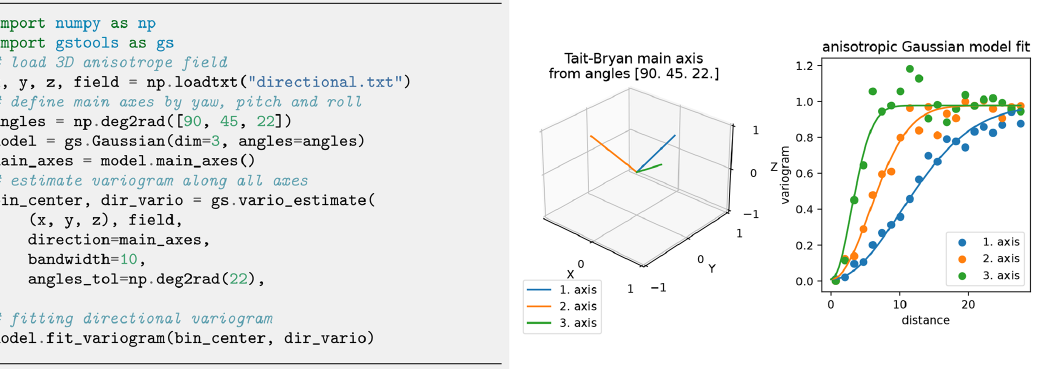
Figure 6. Estimation of directional variograms for given main axes: the code snippet shows the setup for estimating and fitting the variogram to an anisotropic field. The graphs show the main axes of the rotated model and the fitting results. Plotting commands have been omitted.